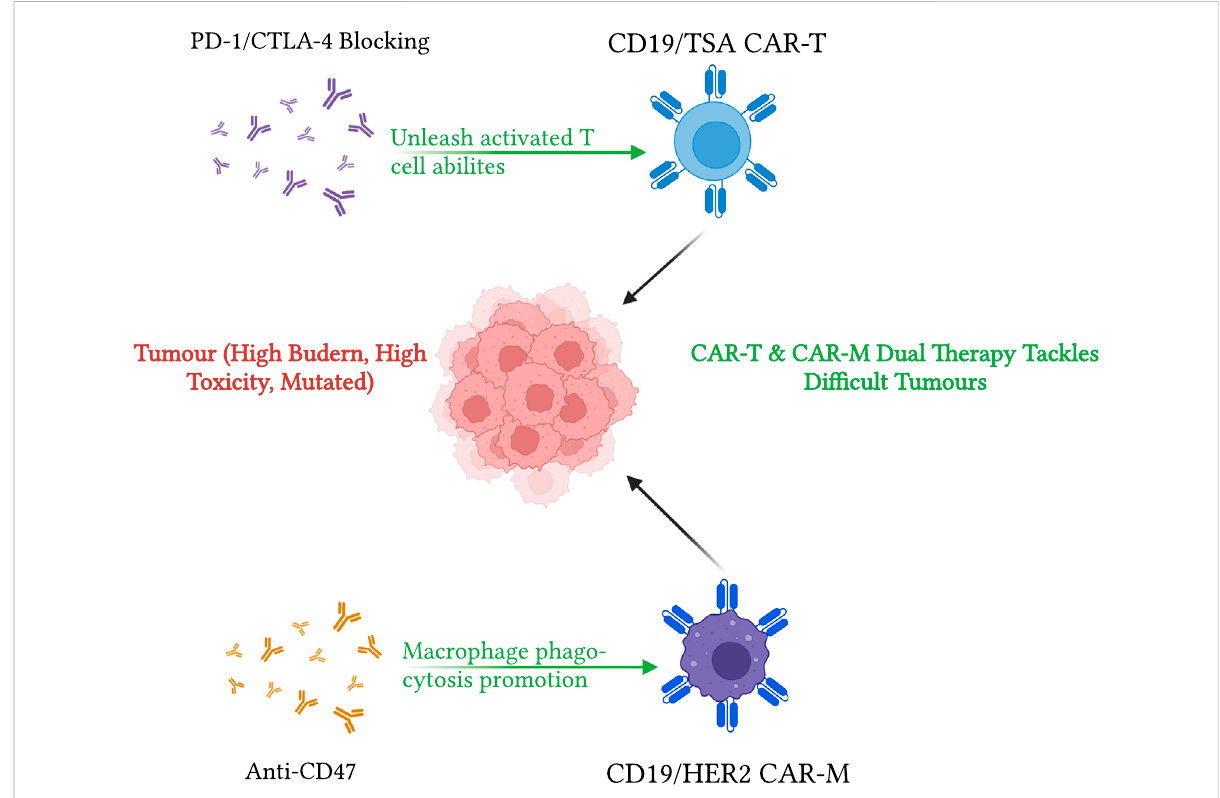
FIGURE 2 Summary of CAR-T in action and limitation of CAR-T immunotherapies. This diagram summarizes the main limitations and usages of CAR-T immunotherapies.ThetoppartindicatedthethreemainlimitationsofCAR-Tcells:antigenescape — ordownregulation oftargetantigenuponCAR- T activation, limited tumour in fi ltration due to toxic tumour microenvironment (TME), and T cell exhaustion as toxicity side effects of CAR-T. On the otherhand,usingCD-19targeting(forhaematologicalmalignancies)andglycoproteinortumour-associatedAntigone(TAA)targeting(forsolid tumours), CAR-T cells demonstrate excellent antitumor effects in clinical conditions. On top of that, dual CAR constructs and Tandem CAR constructs methods may be used to aid antigen escape effects. Diagram produced with